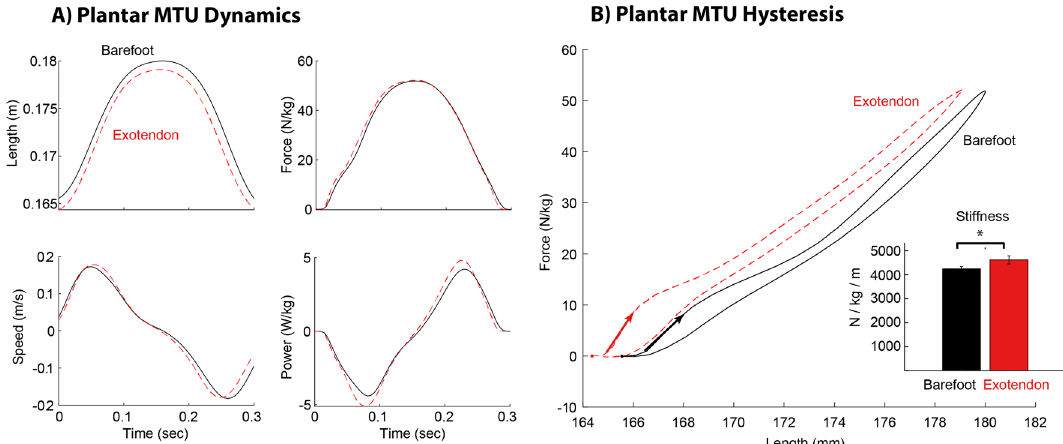
Figure 5. ( A ) Modelled dynamics of the plantar MTU, averaged across participants and compared between barefoot (solid black line) and exotendon (dashed red-line) ( B ) Force–displacement graph of the plantar MTU with arrows are located at initial contact for the hopping cycle and denote the stiffness at that time. Inset bar plot shows the difference in the estimated linear stiffness of the MTU between barefoot and exotendon